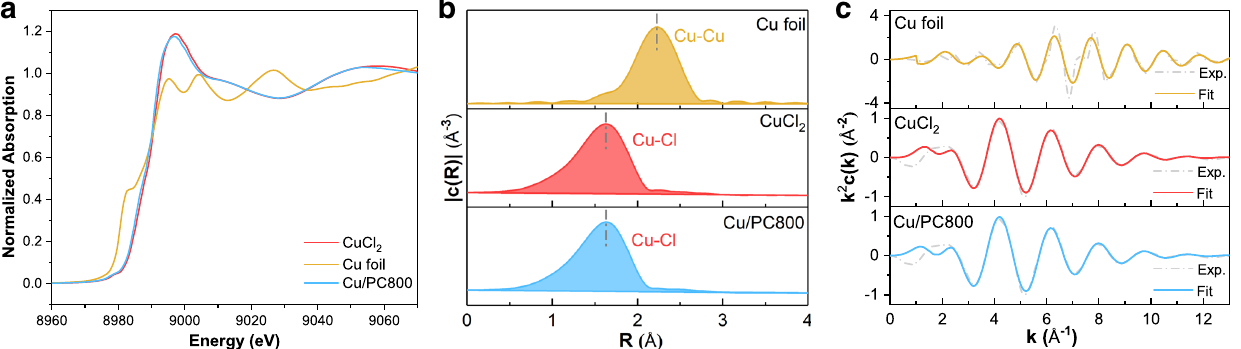
Fig. 6 Oxidation state and coordination environment of active component Cu. a Cu K-edge-normalized XANES spectra of the sample and reference material, b Fourier-transformed magnitude of Cu foil, CuCl 2 , and Cu/PC800 (no phase correction). Experimental and fi tted EXAFS spectra at the Cu K-edge of the selected catalysts, c